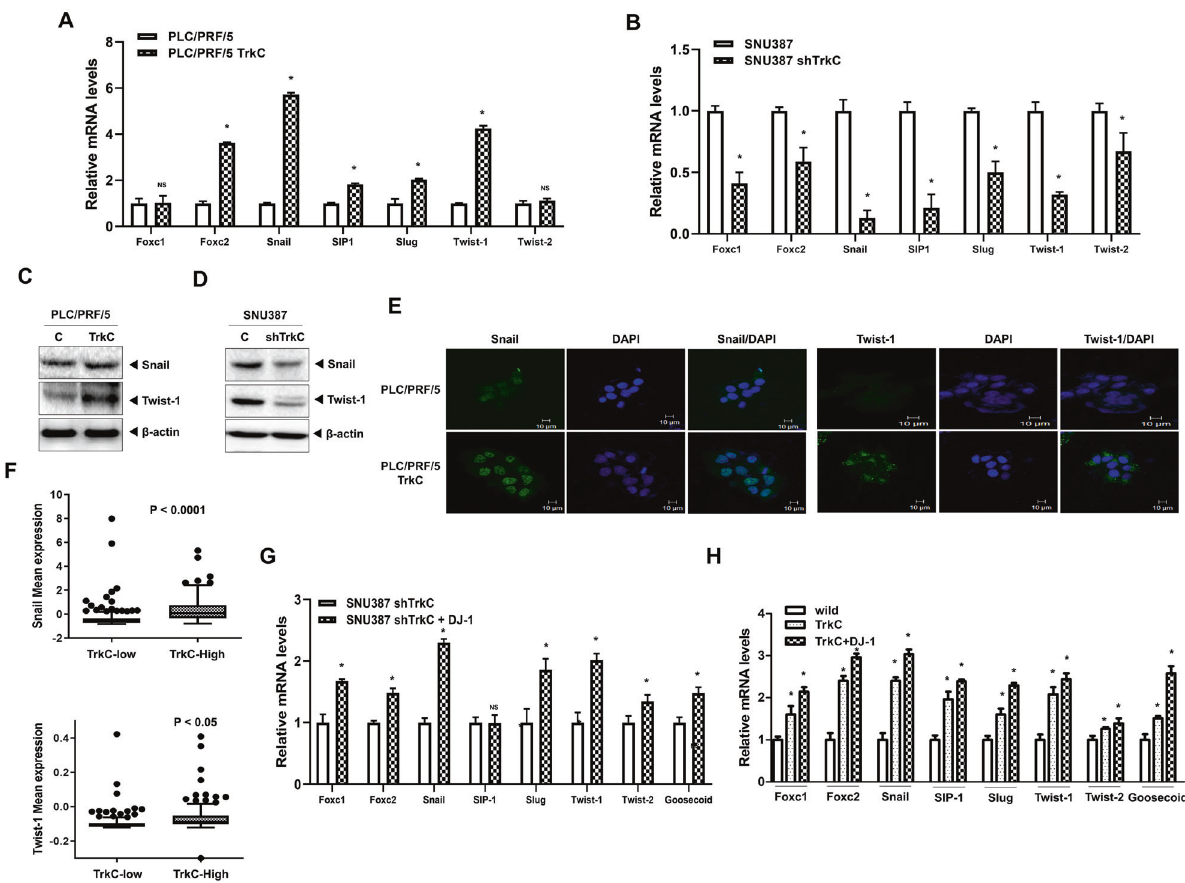
Fig. 7 Upregulated TrkC induces the EMT program via induction of EMT-TFs. A The relative mRNA levels of EMT-TFs (Foxc1, Foxc2, Snail, SIP1, Slug, Twist-1, Twist-2, and Goosecoid) in PLC/PRF/5 or PLC/PRF/5 TrkC cells. n = 3. P < 0.05 (*) relative to PLC/PRF/5; NS: not signi fi cant; t - test. B The relative mRNA levels of EMT-TFs in control SNU387 or TrkC knockdown cells. n = 3. P < 0.05 (*); NS: not signi fi cant; t -test. C Immunoblo t analysis of Snail and Twist-1 in PLC/PRF/5 or PLC/PRF/5 TrkC cells. β -actin as a loading control. D Immunoblot analysis of Snail and Twist-1 in control SNU387 or TrkC knockdown cells. β -actin as a loading control. E Immuno fl uorescence analysis of Snail and Twist-1 in PLC/PRF/5 or PLC/PRF/5 TrkC cells. The nuclei of cells were stained with DAPI (blue). F The relative mRNA expression of Twist-1 and Snail in human HCC patients between high or low TrkC expression. The average expression value of Twist-1 and Snail from the TCGA datasets was determined, rank-ordered, and then divided into two equal groups . P < 0.0001, t -test. G The relative mRNA levels of EMT-TFs in SNU387 TrkC- shRNA cells transfected with or without DJ-1. n = 3. P < 0.05 (*); NS: not signi fi cant; t -test. H The relative mRNA levels of EMT-TFs in PLC/PRF/5 cells transfected with or without DJ-1 or TrkC. n = 3. P < 0.05 (*); NS: not signi fi cant; t